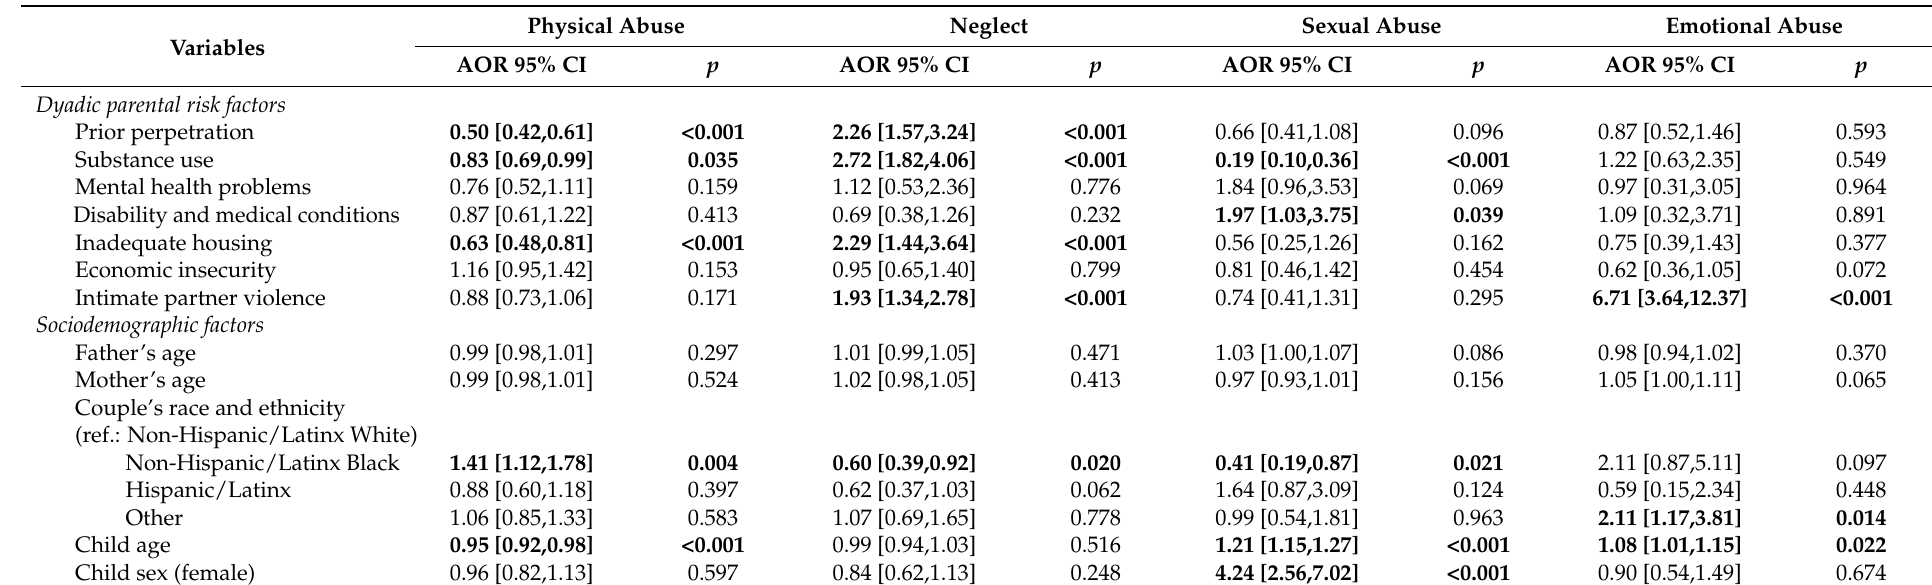
Table 2. Results of Multivariable Logistic Regression Models Predicting Different Child Maltreatment